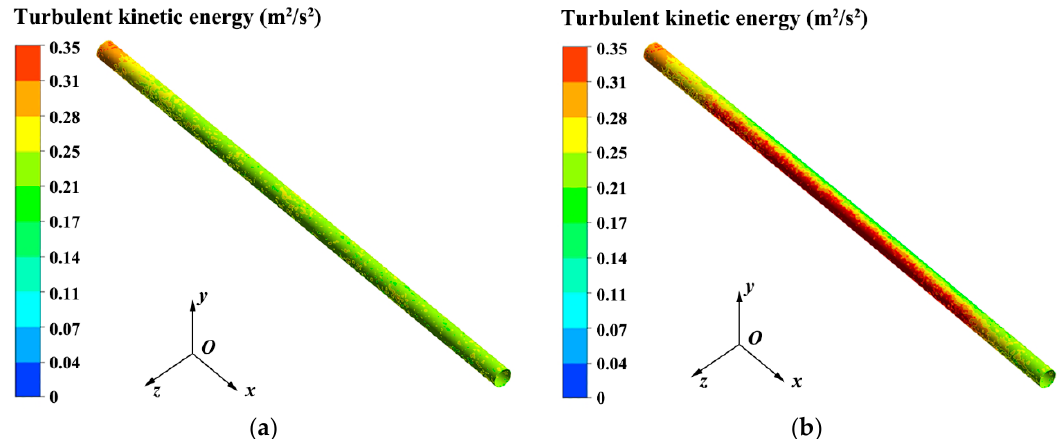
Figure 13. Turbulent kinetic energy contours near the pipe wall: ( a ) t = 0 s; ( b ) t = 0.01 s.